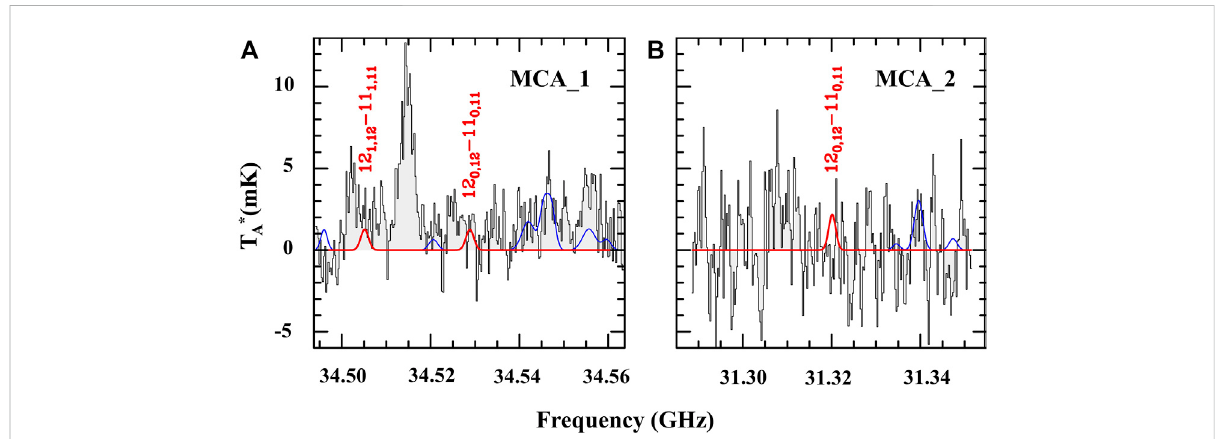
FIGURE 5 The brightest transitions of MCA_1 (panel (A) ) and MCA_2 (panel (B) ) according to the Local Thermodynamic Equilibrium (LTE) towards the G+0.693-0.027 molecular cloud. The synthetic spectrum (red solid line) is derived using the upper limits to the column densities for the typical parameters ( T ex , FWHM, and V LSR ) found in this source, as outlined in the text. The black solid line and gray histogram correspond to the observed spectra towards the source. The blue solid line shows the contribution from other molecular species already identi fi ed in the spectral survey.